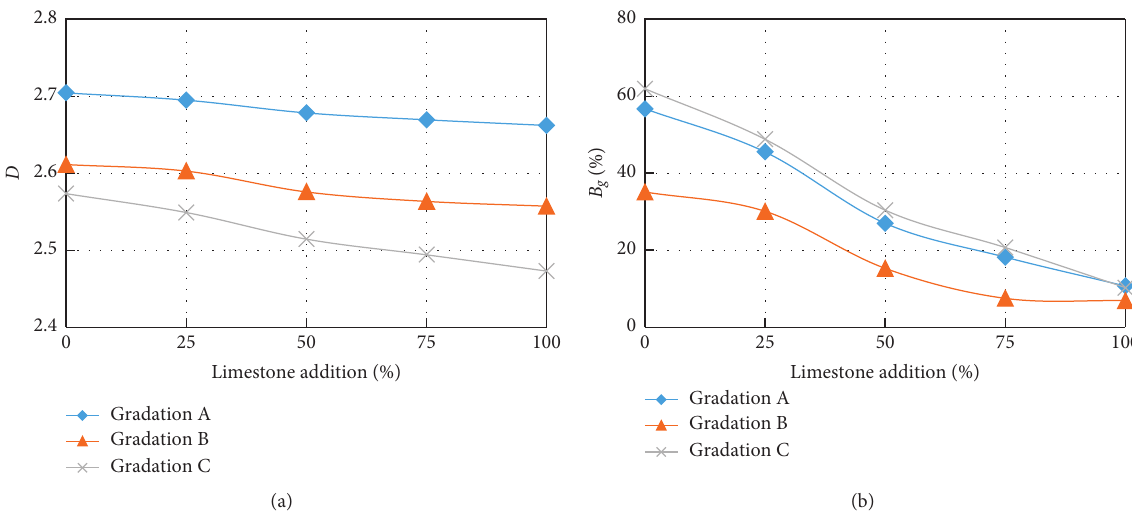
Figure 4: Evaluation of particle breakage with different limestone addition: (a) fractal dimension D and (b) breakage rate B